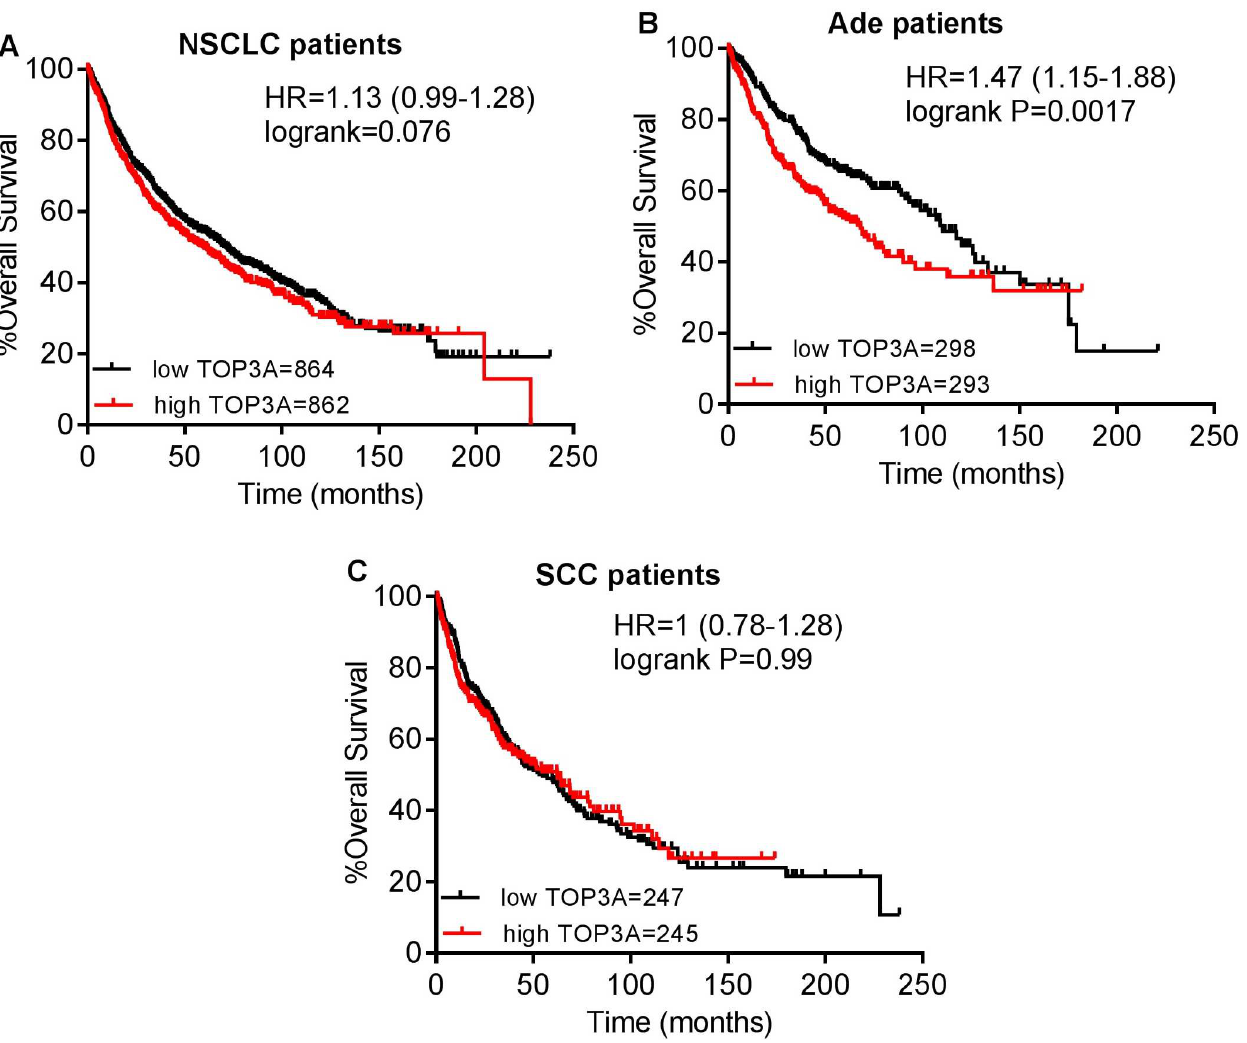
Fig 6. The prognostic value of TOP3A expression. (A) Survival curves were plotted for all NSCLC patients (n = 1726). (B) Survival curves were plotted for Ade patients (n = 591). (C) Survivalcurves were plotted for SCC patients (n = 492). Data was analyzedusing Kaplan-Meier Plotter. Patients with expressionabove the median are indicatedin red line, and patients with expressions belowthe medianin black line. HR means hazardratio.